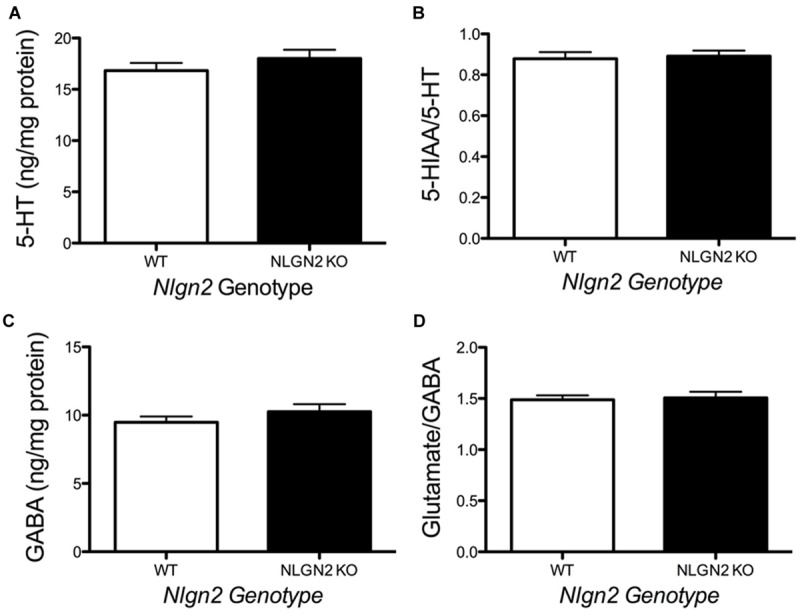
Loss of NLGN2 expression does not impact steady state 5-HT homeostasis. Mice have normal midbrain 5-HT levels and 5-HT turnover ratios (A,B, N = 11 for WT and N = 9 for null), as well as GABA levels and glutamate/GABA ratios (C,D, N = 8 for WT and N = 5 for null). P > 0.05, Student’s t-test.